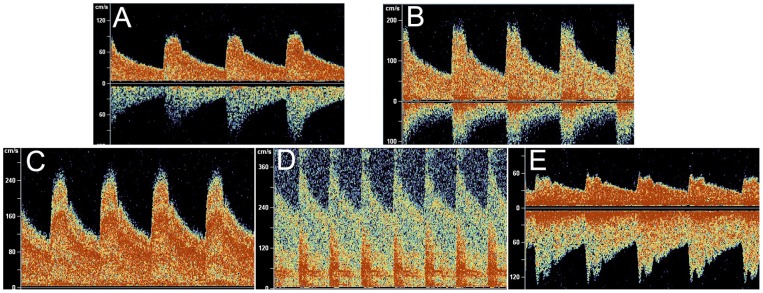
The blood flow spectrum of normal and stenosed MCA.A. Normal MCA; B. Mild MCA stenosis: mild stenosis was defined as systolic peak velocity 140 to 209 cm/s; C. Moderate MCA stenosis: moderate stenosis was defined as a systolic peak velocity from 210 to 280 cm/s; D. Severe MCA stenosis: severe stenosis was defined as a systolic peak velocity >280 cm/s; E. Occlusive of MCA: We diagnosed occlusion of the MCA if all the basal arteries except the MCA in question were detectable or if the asymmetry index of the affected MCA was<−21% compared with the contralateral MCA with the hemodynamic changes of the intracranial circulation.